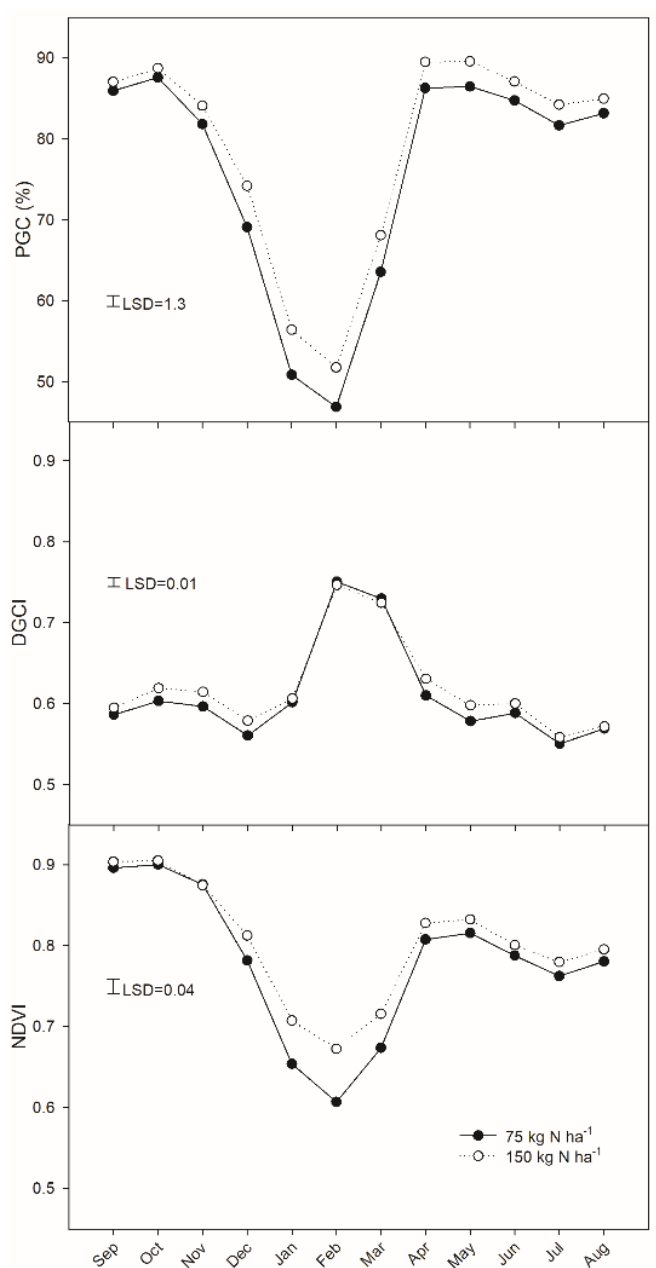
Figure 3. Percent green cover (PGC), dark green color index (DGCI), and NDVI of four tall fescue cultivars (‘Lexington’, ‘Rhambler SRP’, ‘Rhizing star’, and ‘Thunderstruck’) as affected by month. Data are averaged over 2 N rates, 2 years, and 3 replicates, and represent an average of 12 data points. Percent green cover and DGCI, were determined through digital image analysis, NDVI was measured with Field-Scout CM 1000 m.